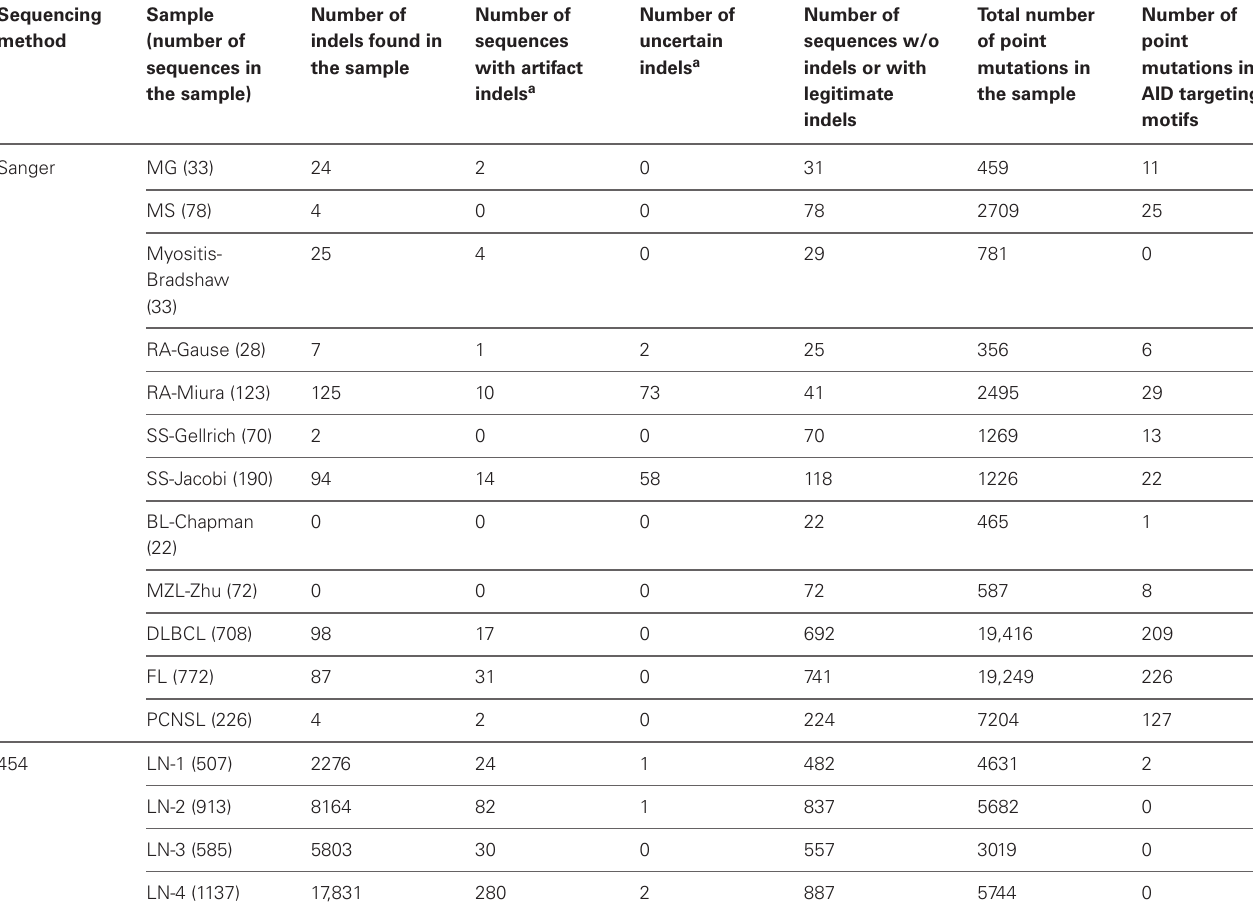
Table 6 | Numbers of Sanger and 454 sequences after Ig-Indel-Identifier cleaning. Sequencing